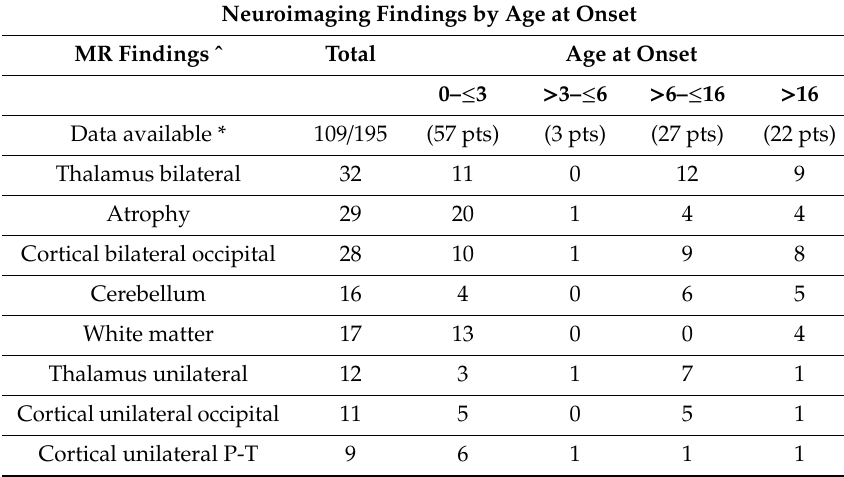
Table 3. Neuroimaging findings by age at